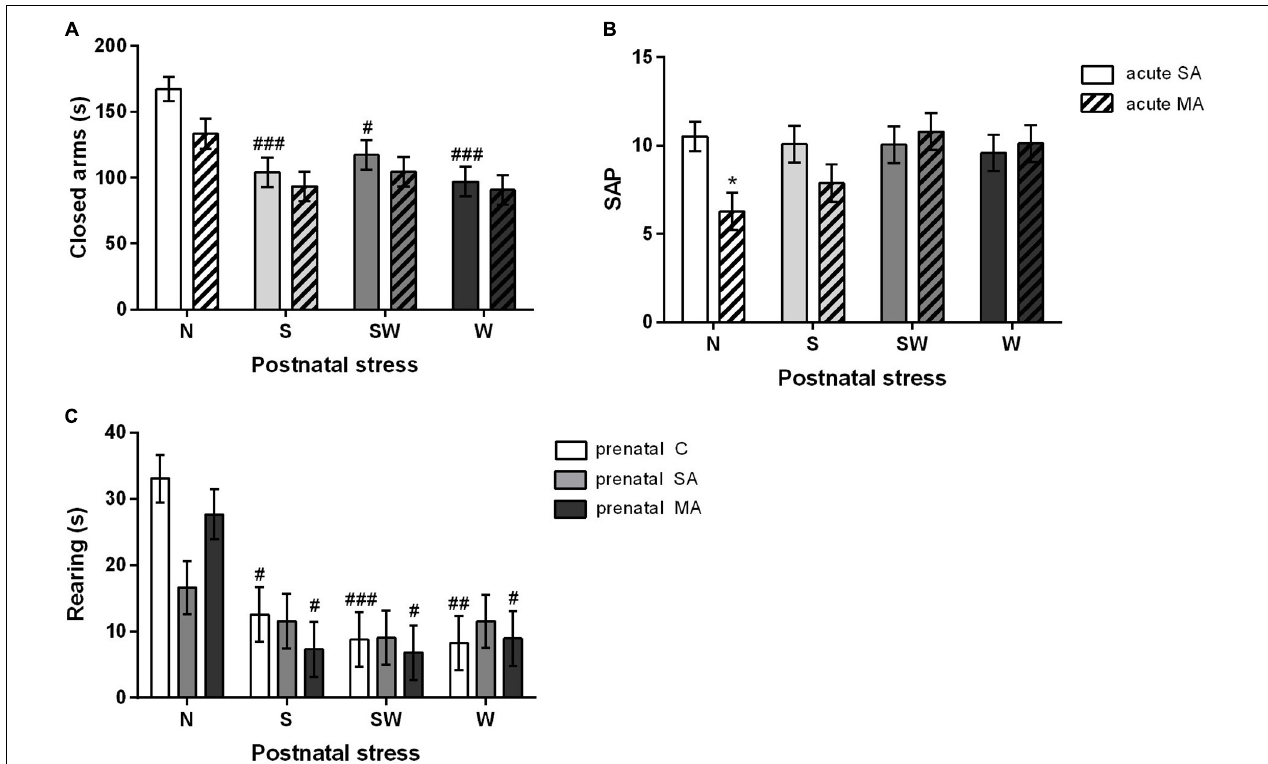
FIGURE 5 | The effect of postnatal treatment and acute MA administration on anxiety-like behavior in elevated plus maze test. (A) Time spent in the closed arms, (B) frequency of the stretched attend posture, and (C) rearing time. Values are means ± SEM. C, control; SA, saline; MA, methamphetamine; N, non-stressed controls; S, maternal separation; W, maternal cold water swimming stress; SW, maternal separation plus maternal cold water swimming stress. Acute SA indicates a single direct saline injection prior to testing, and acute MA indicates a single direct methamphetamine injection prior to testing. * p < 0.05, ** p < 0.01, *** p < 0.001 significant differences in one group on the x -axis. # p < 0.05, ## p < 0.01, ### p < 0.001 significant differences between the group in the legend and its N